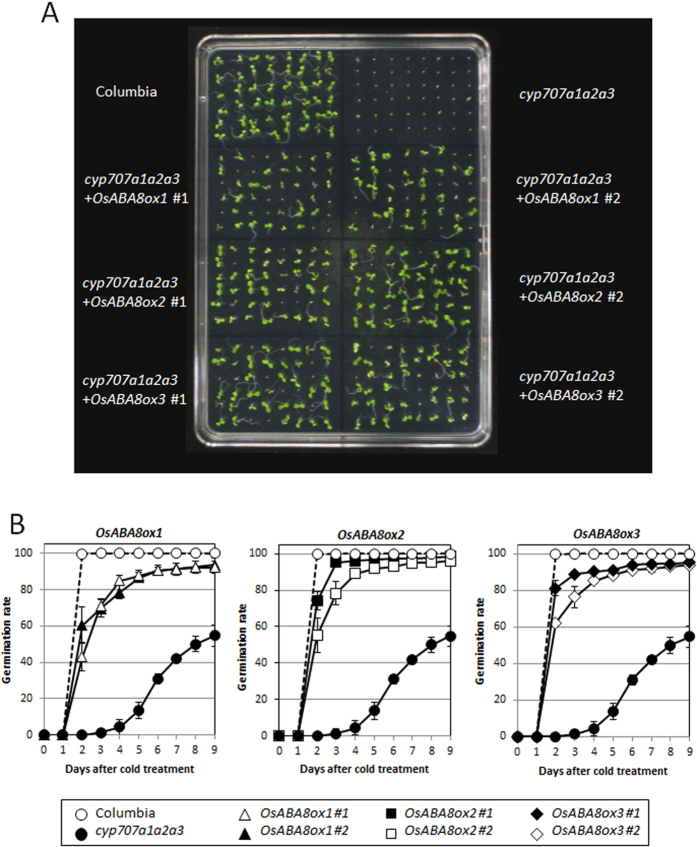
Complementation by OsABA8ox1, OsABA8ox2, or OsABA8ox3 in the cyp707a1a2a3 triple mutant.(A) Typical images of germination of wild-type (Columbia), triple mutant, and transgenic plants. (B) Germination rates of wild-type, cyp707a1a2a3, and transgenic plants after cold treatment. Values are means ± SD of four replicates.